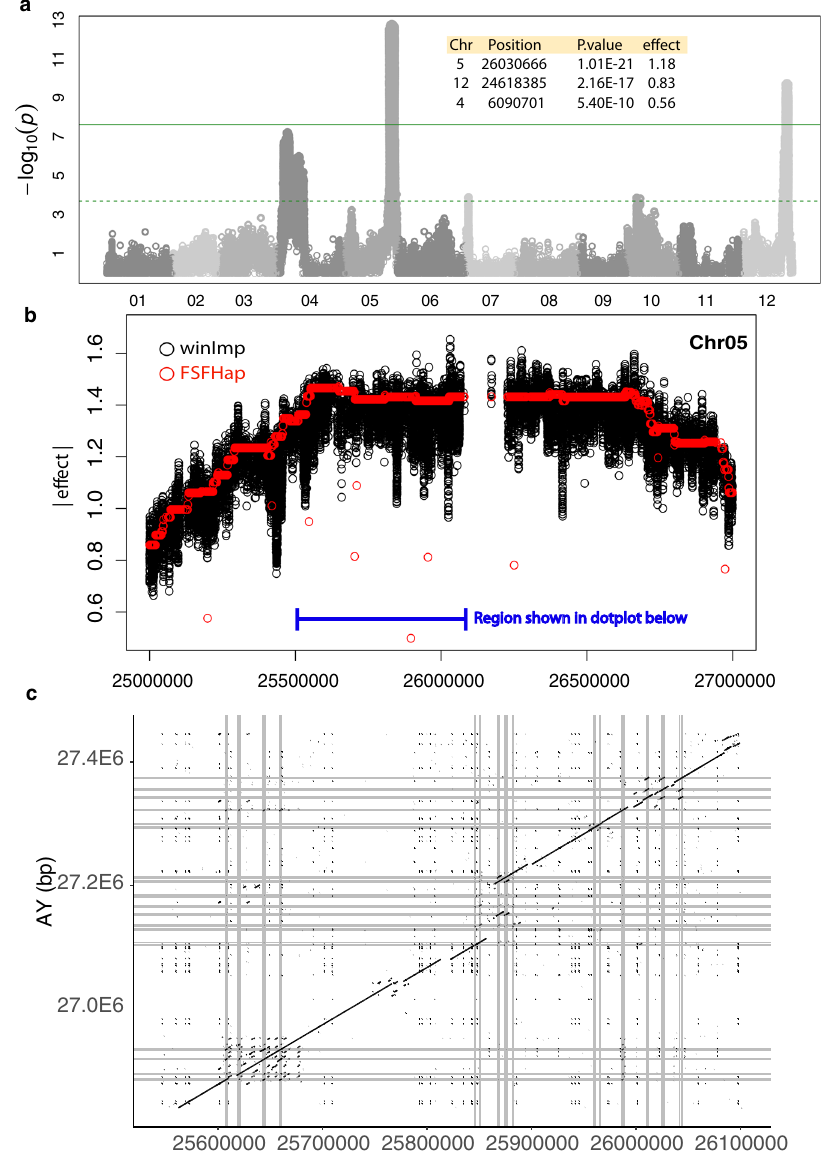
b Detailed view of estimated effect size around the Chr05, large-effect QTL under both winImp and FSFHap imputation. c Dotplot of association plateau region between AY and MR1. Gray bars indicate positions of NBS-LRR homology. Source data are provided as a Source Data fi